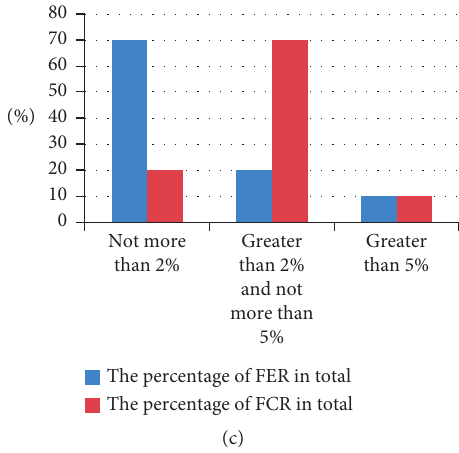
Figure 5: Bar graphs of the percentage of FER and FCR, in total, for each horn-gear system according to Tables 3–5. (a) Percentage of FER and FCR as a total of HGS1. (b) Percentage of FER and FCR as a total of HGS2. (c) Percentage of FER and FCR as a total of